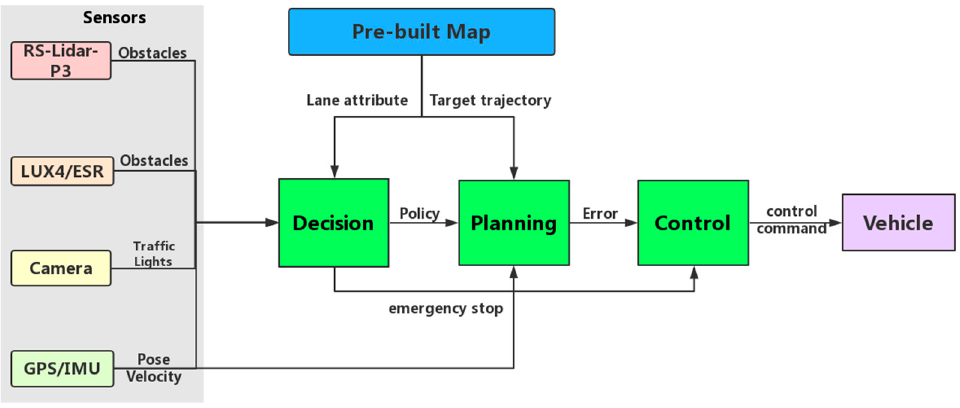
Figure 11. System architecture of Tianjin University’s autonomous vehicle.